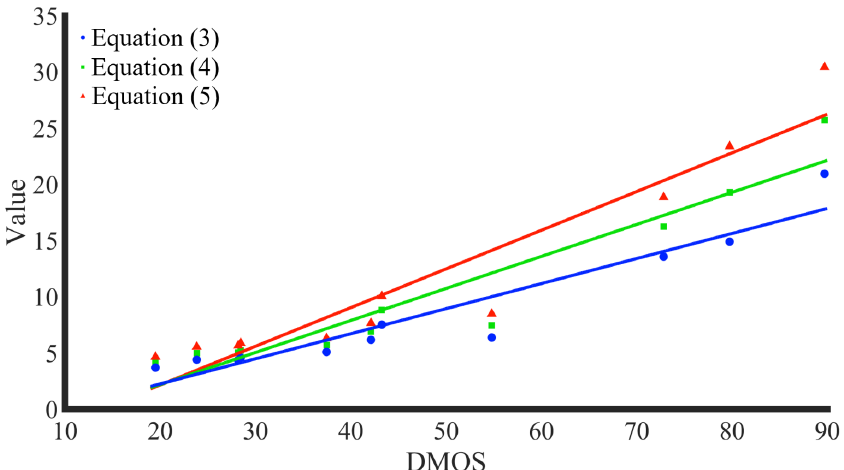
Figure 19. The relationship between the evaluation value and the degree of image blurring when the image contents are not the same.